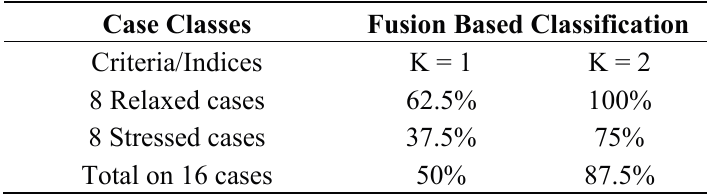
Table 5. Representation of Percentage of correctly classified cases by the fusion based classification considering the fuzzy similarity function.